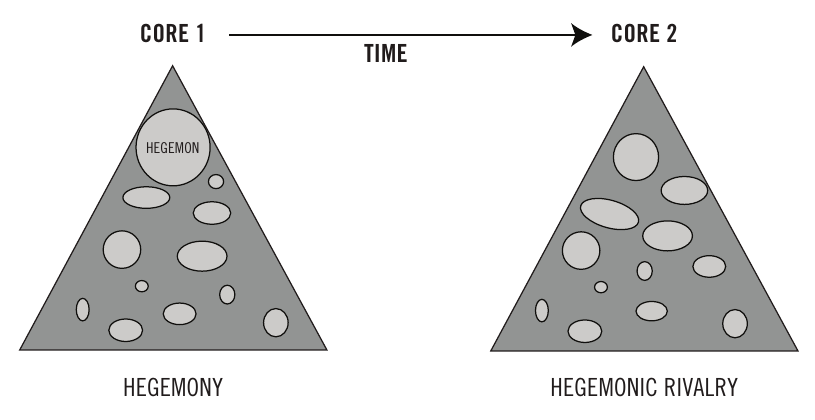
Figure 1 – Core-Wide Empire Compared to Core with Hegemon Figure 2 – The Modern Hegemonic